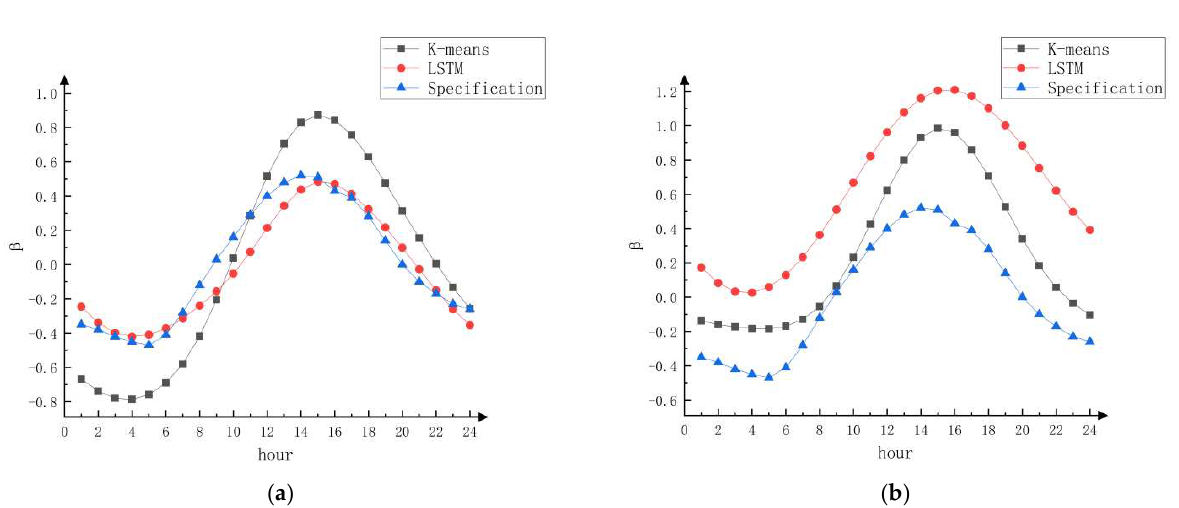
A comparison between the revised value based on K-means clustering and the predicted value of LSTM model and the standard value is shown in Figure 10.